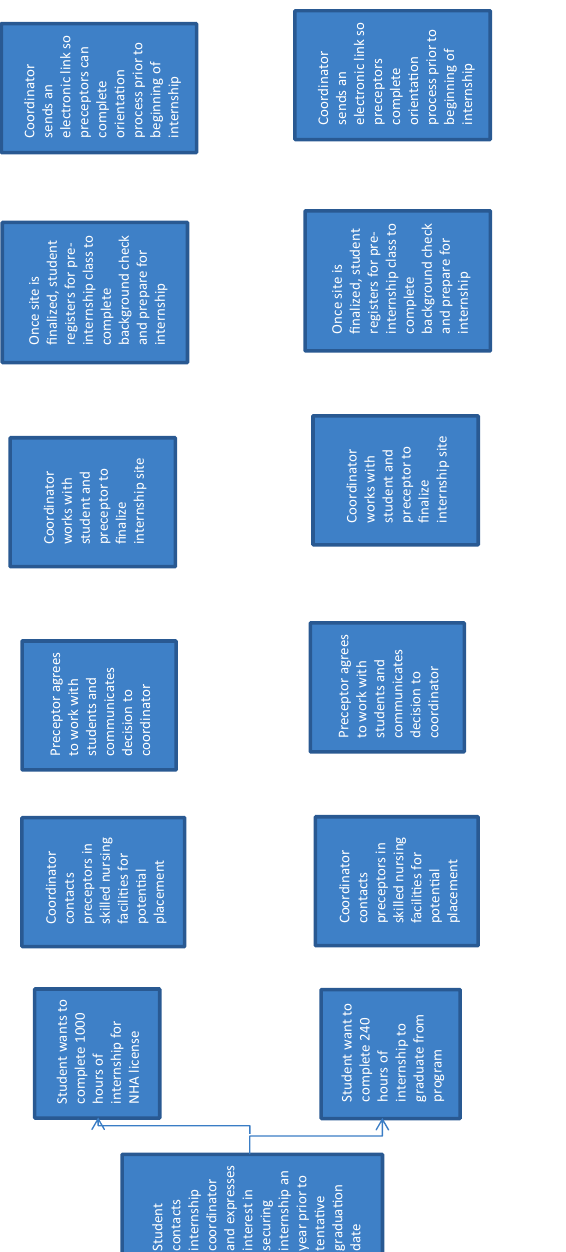
Figure 4. Pull-based internship